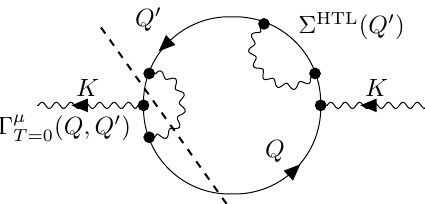
Figure 8. Another cut of the same diagram, contributing to the imaginary part of the polarization tensor Π ( 3 )